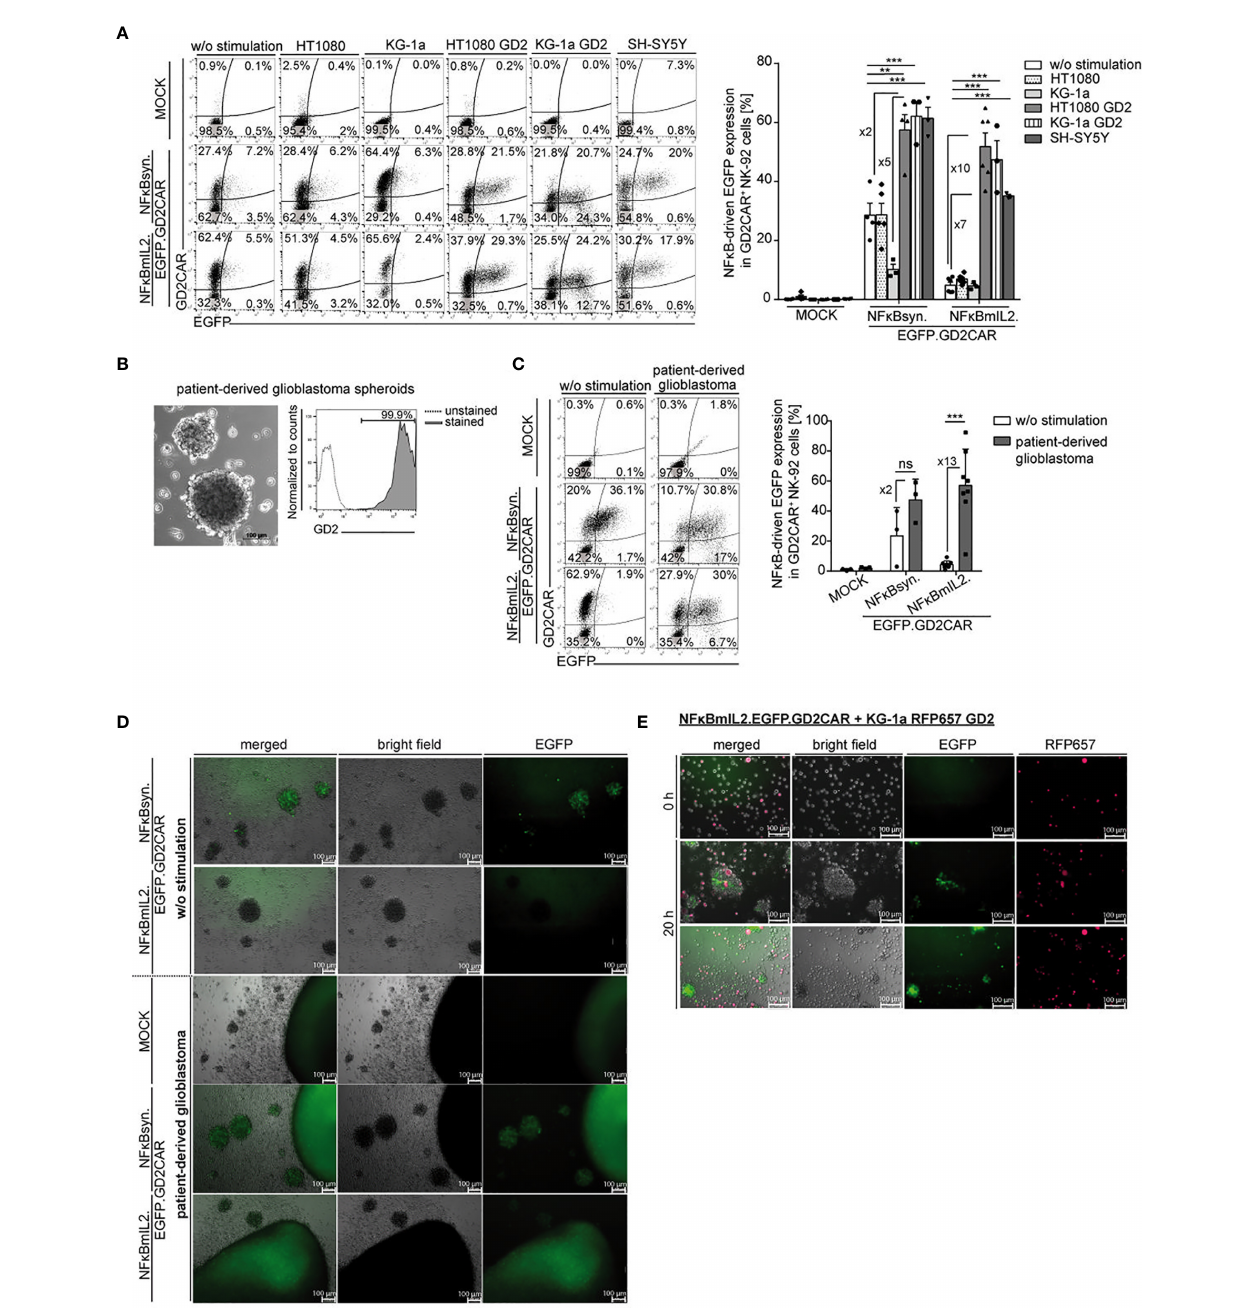
FIGURE 3 | Modi fi cation of NK-92 cells with alpharetroviral SIN NF k B-driven “ all-in-one ” vector constructs led to GD2CAR-mediated EGFP induction. (A) Increased EGFP expression after target-speci fi c stimulation. Exemplary fl ow cytometric analysis of unsorted modi fi ed (MOI 10) NK-92 cells after 24-h of coculture with indicated target cells (E:T 10:1). The bar graph summarizes the inducible NF k B-driven EGFP expression of unsorted modi fi ed (MOI 10) NK-92 cells after 24-h cocultures with indicated target cells (n = 3 – 6). Indicated signi fi cance was determined by one-way ANOVA with Tukey´s multiple-comparison test; ***p ≤ 0.001; **p ≤ 0.01. (B) Bright fi eld picture of patient-derived primary glioblastoma (GBM) cells and fl ow cytometry analysis show GD2 expression of primary GBM cells. (C) Flow cytometric analysis of a 24-h coculture of unsorted modi fi ed (MOI 10) NK-92 cells in the presence or absence of primary GBM cells. The bar graph shows speci fi c NF k B-driven EGFP expression in modi fi ed NK-92 cells (n = 3-8). Indicated signi fi cance was determined by paired t-test; ***p ≤ 0.001. ns, not signi fi cant. (D, E) Immuno fl uorescence microscopy analysis indicated GD2CAR-speci fi c EGFP upregulation after incubation with (D) primary GBM cells or (E) KG-1a RFP657 GD2 cells. Shown are (D) 24-h or (E) 0- and 20-h (two representative pictures with identical culture conditions) cocultures of sorted modi fi ed NK-92 cells and tumor spheroids or suspension target cells. KG-1a RFP657 GD2 cells are indicated in red; NF k B-driven EGFP induction is indicated in green. Mean values +/- SEM are shown in 3A and mean values +/- SD are shown in 3C. Untransduced NK-92 cells were termed